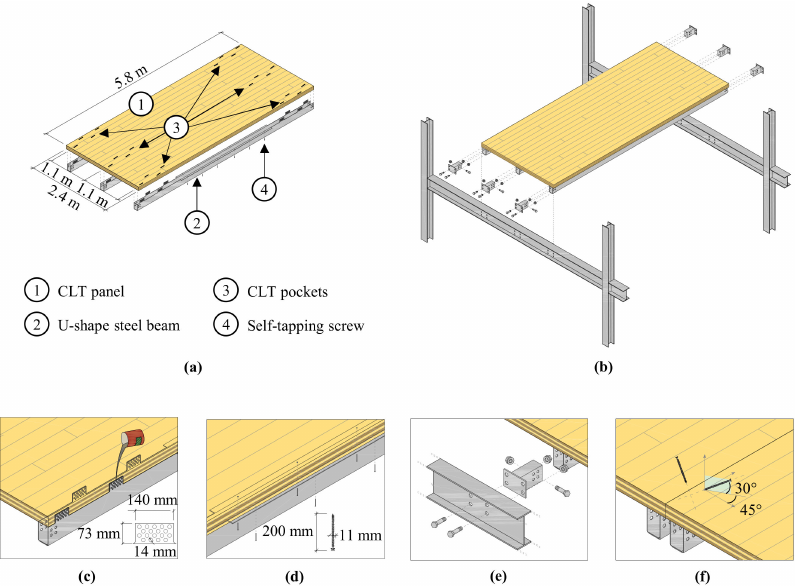
Figure 3. Prefabricated floor units ( a ); Dry assembly of floor units ( b ); Joints overview: CLT-to- beam steel-timber connections ( c , d ), Beam-to-beam steel connections ( e ), and CLT-to-CLT timber connections ( f